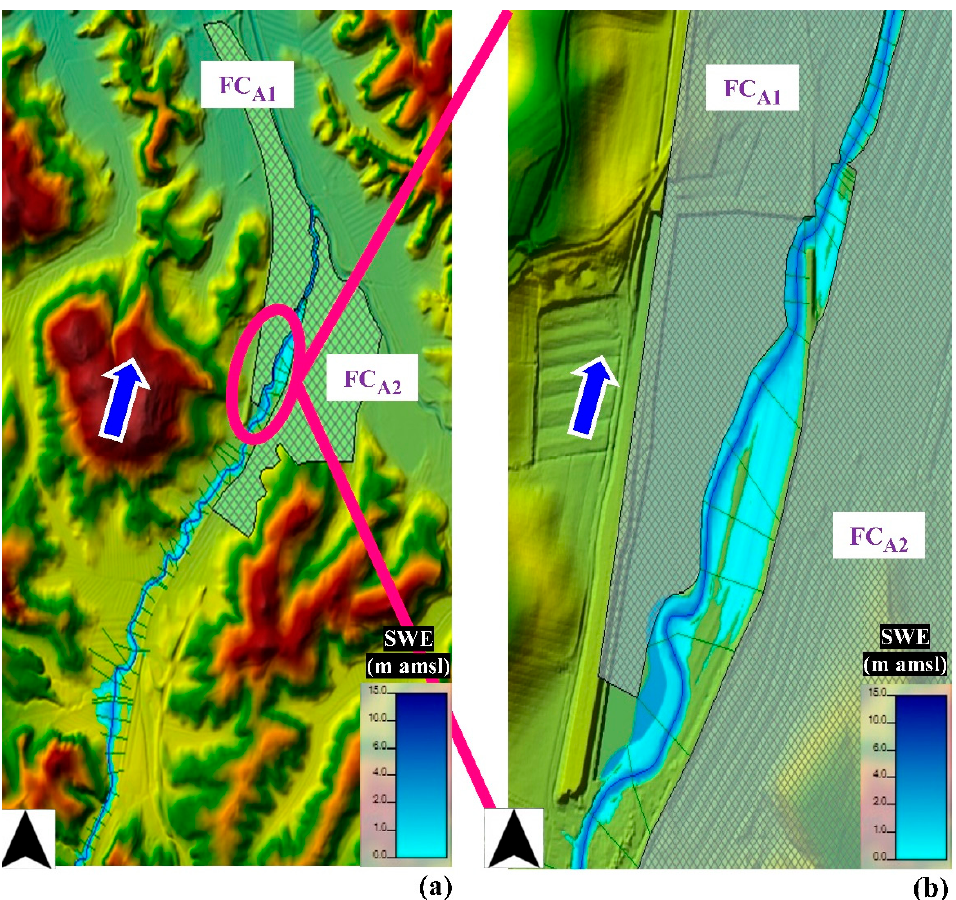
Figure 10. ( a ) Surface water elevations SWE (m a.m.s.l.) outcoming from the 2D unsteady simulation for Morra Creek. ( b ) Detailed view of the two vegetated flood control areas FC A1 and FC A2 , and corresponding SWE (m a.m.s.l.). The blue arrow indicates the flow direction, while the two soft green polygons represent respectively the modeled flood control areas FC A1 and FC A2 .